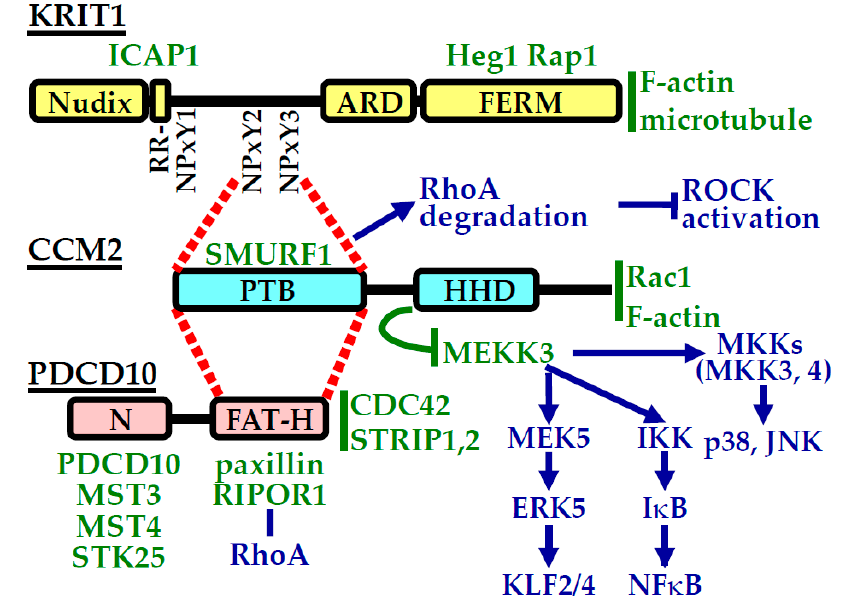
Figure 3. CCM protein domain organization and protein interactions. CCM protein domain organizations are presented schematically. Direct interaction partners are shown in green letters.